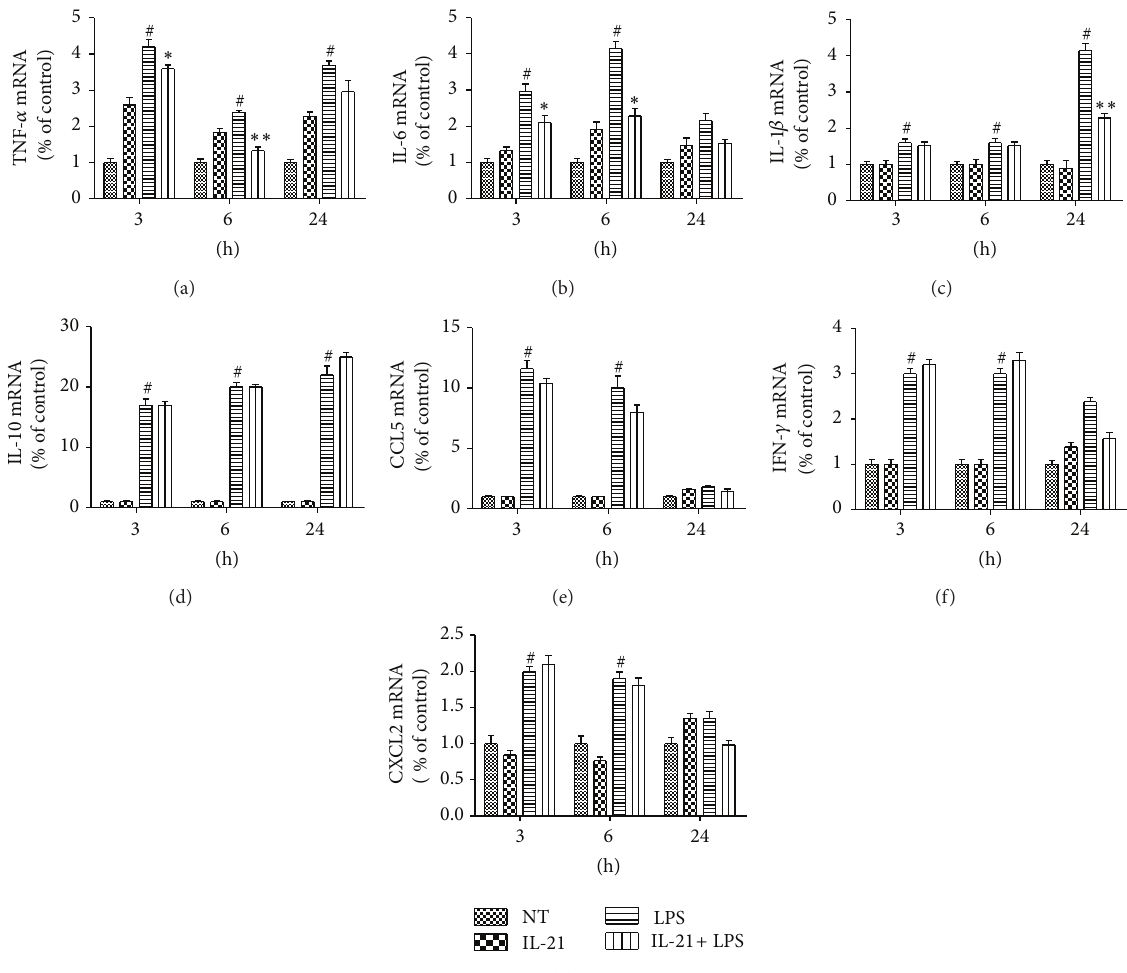
Figure 2: Effects of IL-21 on LPS-induced cytokine and chemokine mRNA expression in mouse peritoneal macrophages. Macrophages were incubated with IL-21 (100ng/mL) in the presence or absence of LPS (100ng/mL) for 3h, 6h, and 24 h. Total RNA was isolated and analyzed by real time RT- PCR for TNF- 𝛼 (a), IL-6 (b), IL-1 𝛽 (c), IL-10 (d), CCL5 (e), IFN- 𝛾 (f), and CXCL2 (g) mRNA expression. All of these expressions were normalized to endogenous control GAPDH. Results are expressed as mean ± SD for each group from three independent experiments. # 𝑃 < 0.001 significantly different from the NT group; ∗ 𝑃 < 0.05 , ∗∗ 𝑃 < 0.01 compared with the LPS